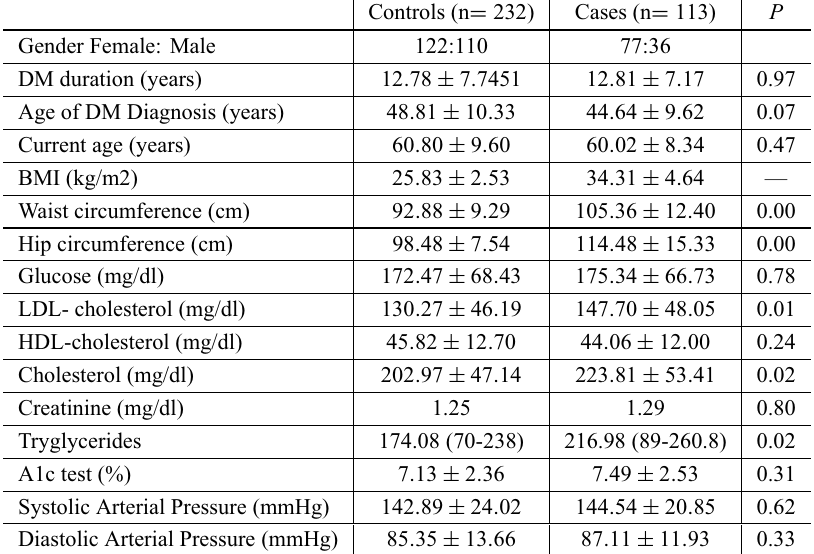
Clinical variables in DM2 patients according to presence of obesity. Controls (n = 232) Cases (n = 113)